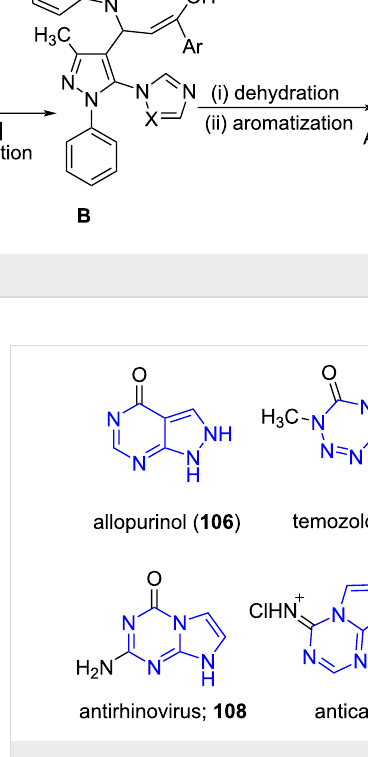
Figure 8: Pharmacologically active molecules containing purine